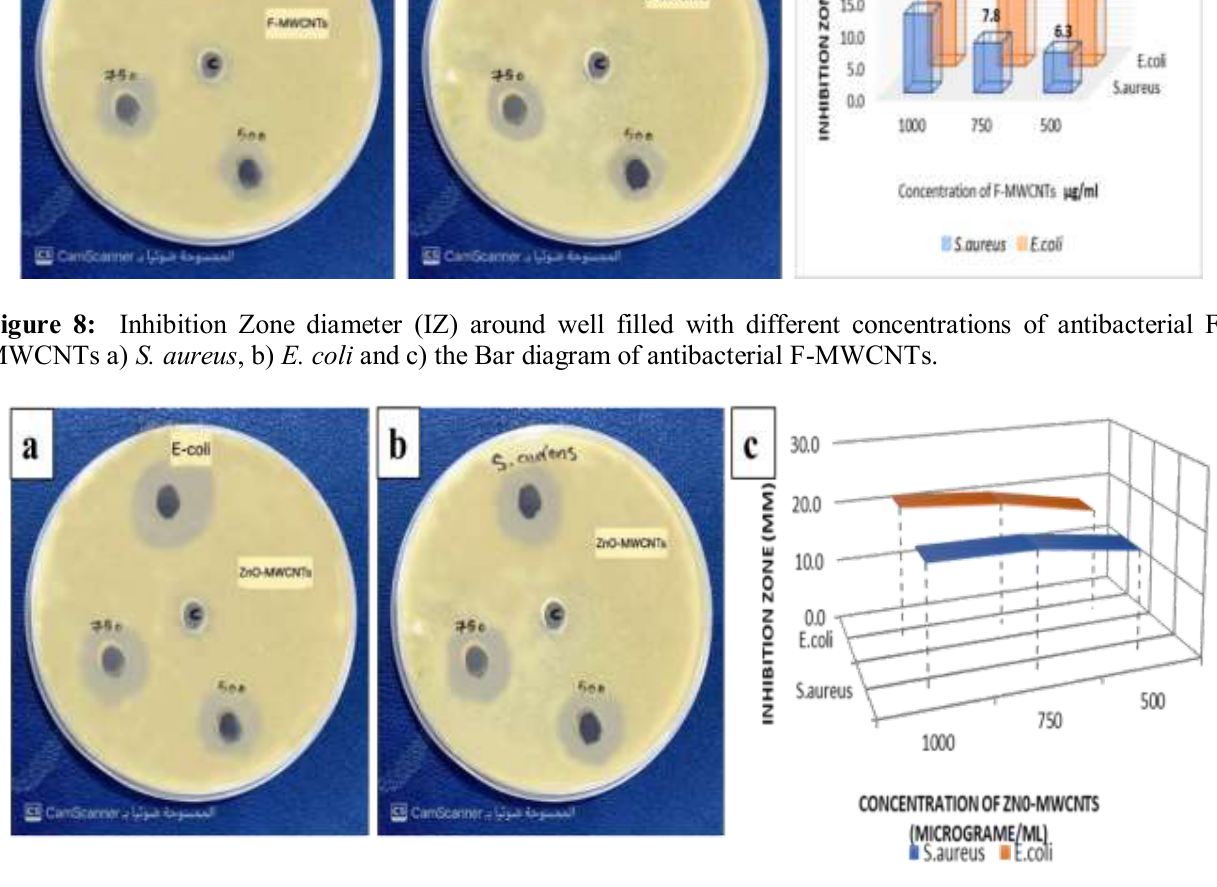
Figure 9: Inhibition Zone diameter (IZ) around well filled with different concentrations of antibacterial ZnO- MWCNTs hybrid a) S. aureus , b) E. coli and c) Bar diagram of antibacterial ZnO\ MWCNTs